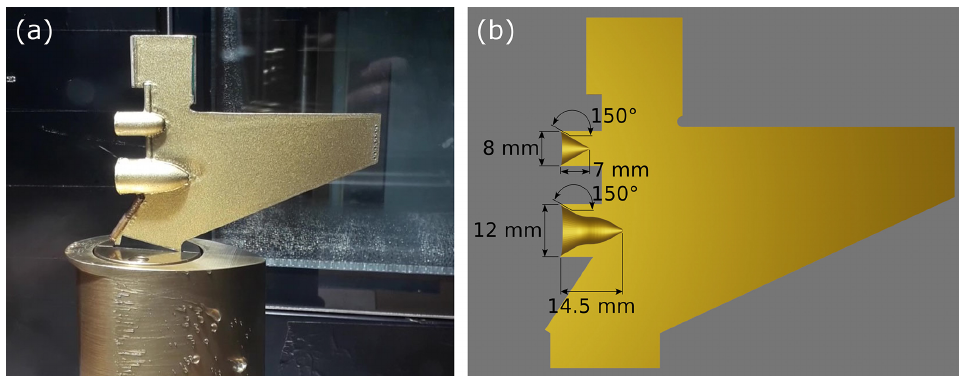
Figure 1. (a) Nevzorov probe in the Braunschweig IWT (BIWT) with the new sensor head, which features an LWC sensor (top), an 8mm TWC collector cone (middle) and the new 12mm TWC collector cone (bottom). The sensor head contains only one reference sensor, which is positioned on the downwind side of the banneret that constitutes the top of the sensor head. (b) Cross section through the new Nevzorov sensor head and approximate dimensions of the sensors. The Nevzorov sensor heads are handmade; therefore small differences may exist between sensor heads that are nominally the same